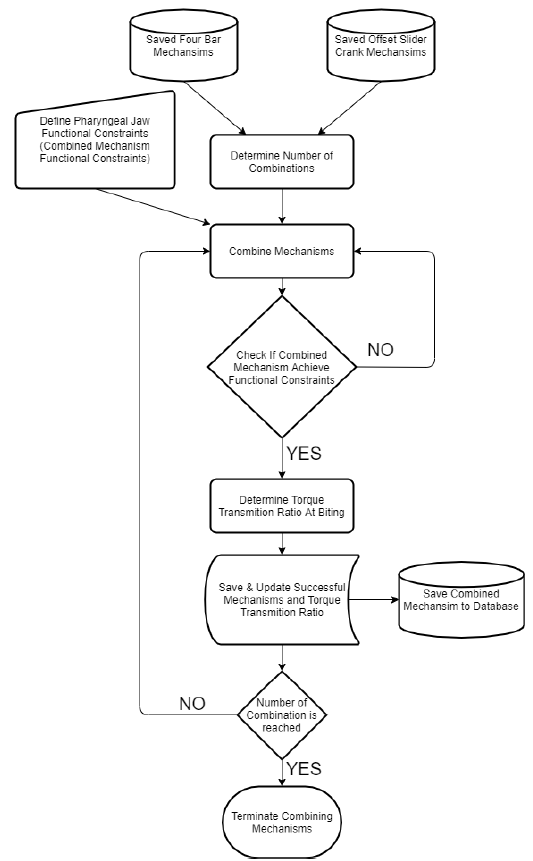
Figure 14. Algorithm for combining the four-bar mechanism and the offset slider–crank mechanism to get a functional pharyngeal jaw.